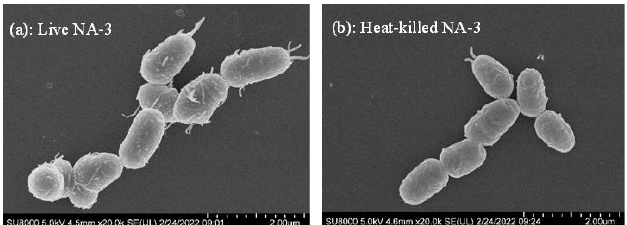
Figure 4. Micromorphology of live ( a ) and heat-killed ( b ) Loigolactobacillus coryniformis